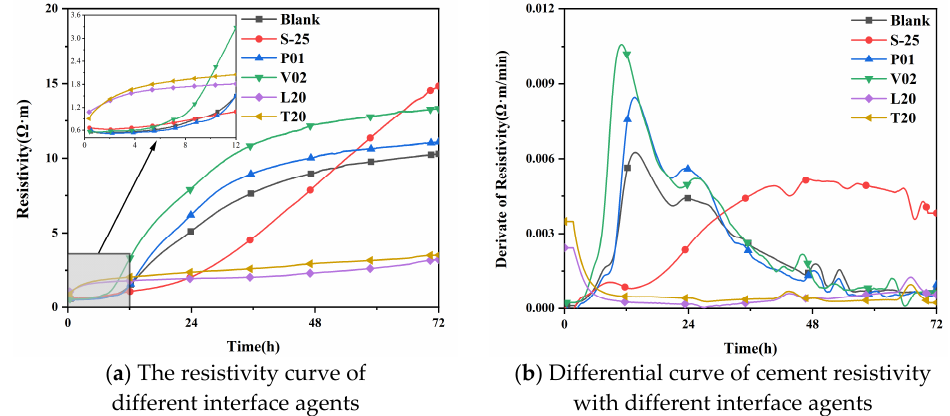
Figure 12. Diagram of the influence of different interface agents on cement resistivity.